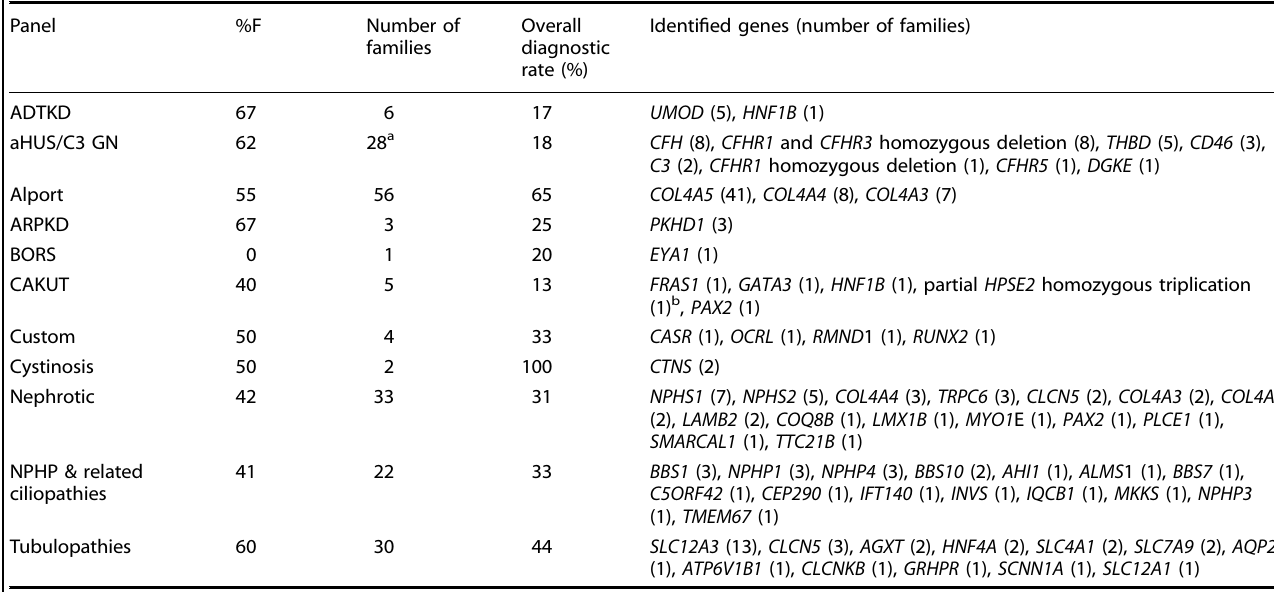
Variant classi fi cation was based on 2015 ACMG guidelines 20 . Diagnostic rate was de fi ned as the proportion of referred families in which a pathogenic or likely pathogenic variant was detected. Sex ratio was abbreviated as %F (percent female). Abbreviated panels are as follows: ADTKD autosomal dominant tubulointerstitial kidney disease, aHUS/C3 GN atypical hemolytic uremic syndrome-C3 glomerulonephritis, Alport Alport syndrome, ARPKD autosomal recessive polycystic kidney disease, BORS branchio-oto renal syndrome, CAKUT congenital anomalies of the kidney and urinary tract, Nephrotic nephrotic syndrome, NPHP & related ciliopathies nephronophthisis & related ciliopathies. a Two likely pathogenic/pathogenic variants were found in one family. b Unaffected parents con fi rmed heterozygous, affected siblings also